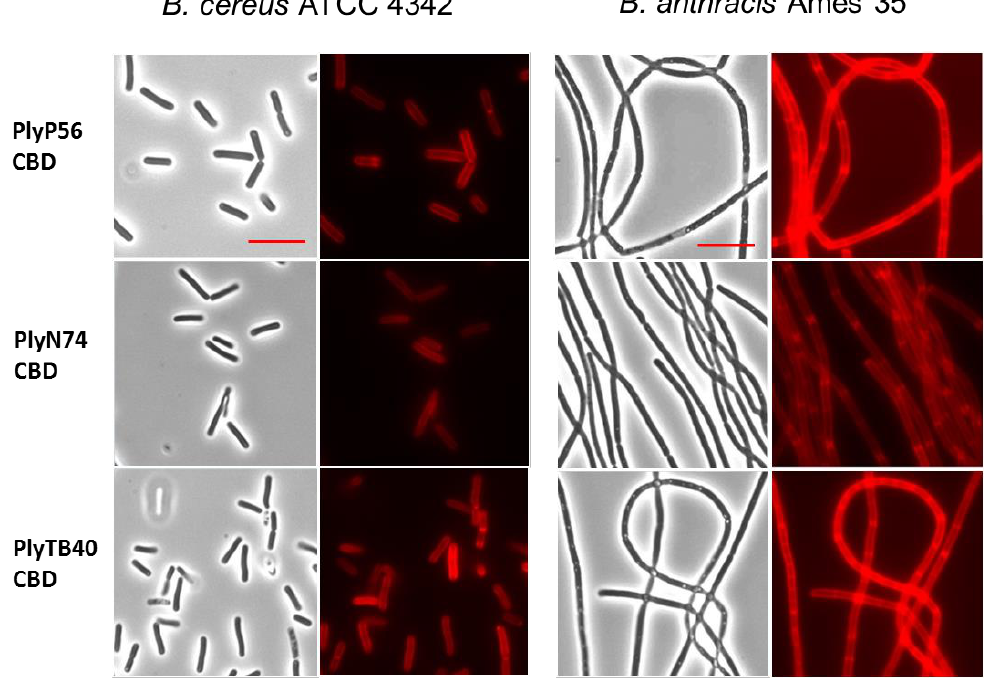
Figure 7. Binding of AlexaFluor-labeled CBDs to a cell wall of bacilli. Decoration of B. cereus ATCC 4342 (two left columns) and B. anthracis Ames 35 (two right columns) by fluorescently tagged CBDs of PlyP56, PlyN74, and PlyTB40. 1000× bright-field images (columns 1 and 3) are shown with their corresponding fluorescent images (columns 2 and 4). The AlexaFluor-labeled CBDs recognize and bind to an evenly distributed ligand on the surface of B. cereus and B. anthracis . Red scale bar = 5 μm.